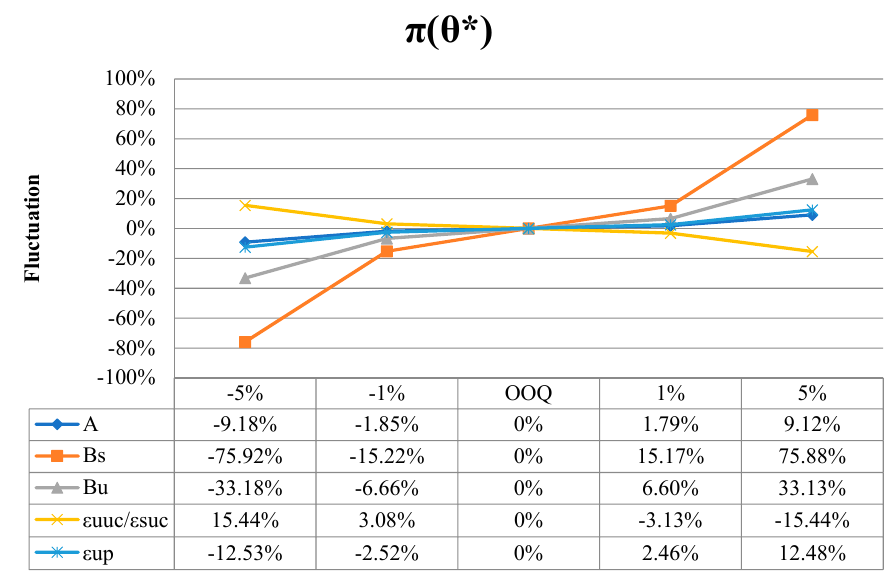
Figure 2. Sensitivity analysis of parameter changes for maximum net profits.